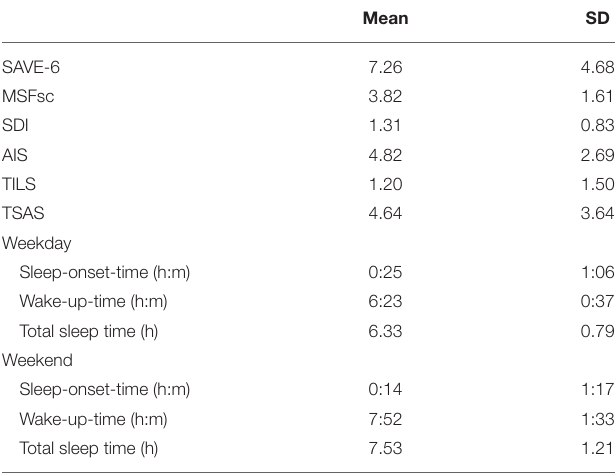
TABLE 1 | Descriptive variables of measures.